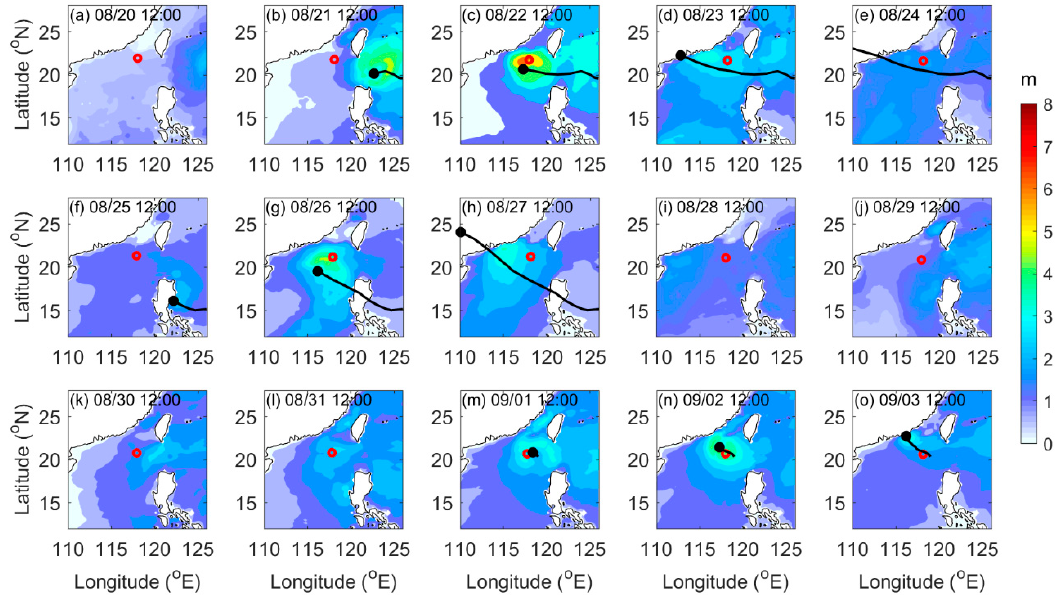
Figure 9. Spectral significant wave height (unit: m) simulated by global wave model MFWAM at 12:00 UTC (Universal Time Code) between August 20 and September 03, 2017. The red hollowed dots depict the position of the wave glider, the black lines depict the tropical cyclone tracks, and the black dots depict the centers of the tropical cyclones ( a – o ).